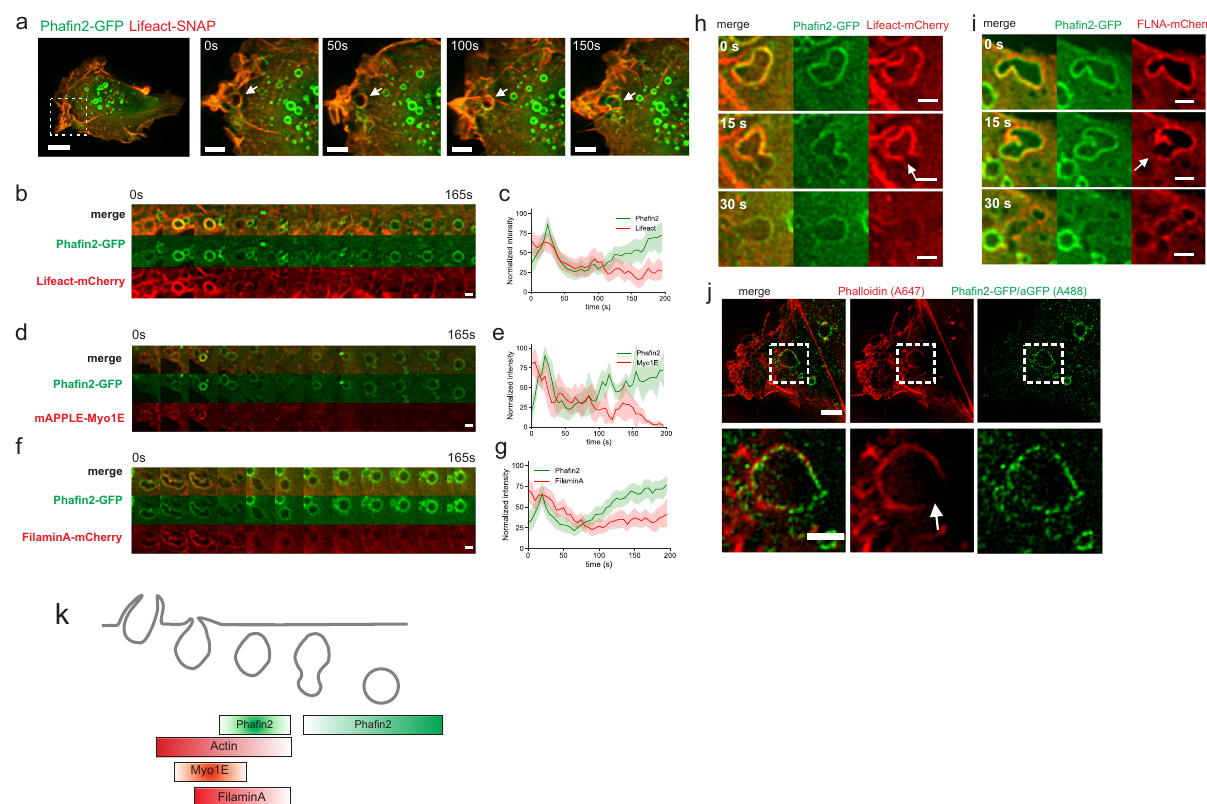
Fig. 6 Pha fi n2 localization coincides with restructuring of the actin cytoskeleton. a Light sheet imaging of RPE1 cells expressing Pha fi n2-GFP and Lifeact- SNAP. Representative image of n = 5 cells. Scale bar: 10 µ m, inset: 5 µ m. b Sequential images showing Pha fi n2 and Lifeact on macropinosomes. Representative image for n = 21 macropinosomes. Scale bar: 1 µ m. c Localization dynamics of Pha fi n2 and Lifeact at macropinosomes. Lifeact localization shows partial temporal overlap with Pha fi n2 localization. n = 21 macropinosomes, mean + 95% CI. d Sequential images showing Pha fi n2 and Myo1E dynamics on a macropinosome. Representative image for n = 6 macropinosomes. Scale bar: 1 µ m. e Myo1E is recruited earlier than the initial Pha fi n2 bursts and shows partial temporal overlap during the fi rst phase of Pha fi n2 recruitment. n = 6 macropinosomes, mean + 95% CI. f Sequential images of Pha fi n2 and FilaminA on a macropinosome. Representative images for n = 46 macropinosomes. Scale bar: 1 µ m. g Localization dynamics of Pha fi n2 and FilaminA on macropinosomes. n = 46 macropinosomes, mean + 95% CI. h Sequential images showing that actin (visualized by Lifeact) forms a coat around Pha fi n2-positive macropinosomes. Gaps in the actin coat allow the passage of the Pha fi n2-labeled vesicle (arrow). Representative image for 18 cells. Scale bar: 1 µ m. i Sequential images showing that FilaminA forms a coat around Pha fi n2-positive macropinosomes. Gaps in the FilaminA coat allow the passage of the Pha fi n2-labeled vesicle (arrow). Representative image for 20 cells. Scale bar: 1 µ m. j SIM super-resolution image showing a Pha fi n2-positive macropinosome passing a gap in the actin cytoskeleton (arrow). Representative image for ten cells. Scale bar: 10 µ m, inset 2 µ m. k Schematic overview of the observed recruitment dynamics. Statistics source data for b , d , and g are provided in this (Fig. 7f, g, Supplementary Movie S21), indicating that membrane- localized Pha fi n2, and not simple overexpression of Pha fi n2 Δ C, triggers these phenotypes.